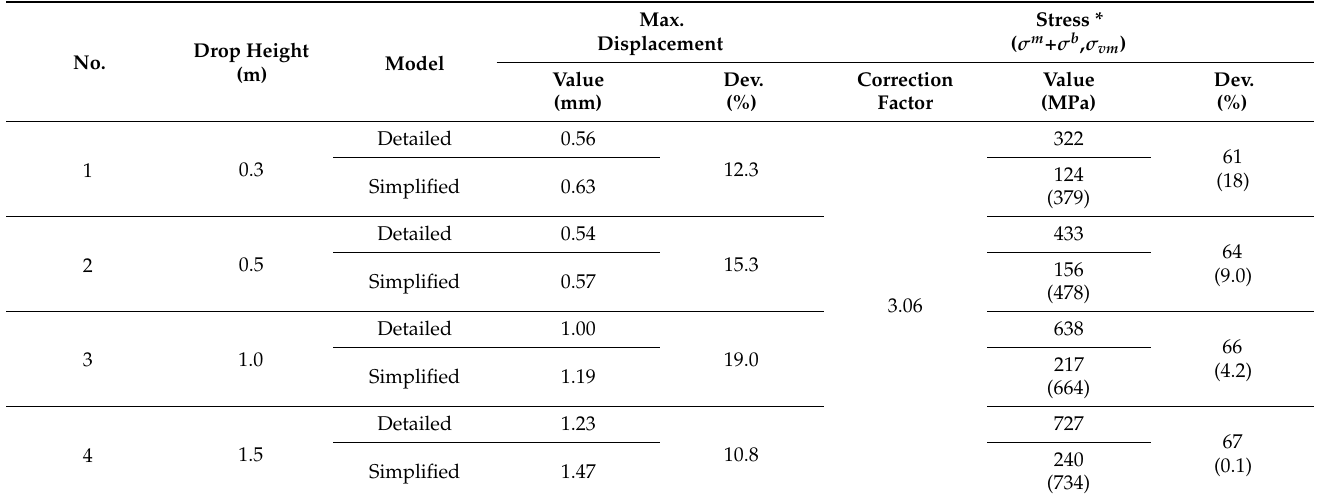
Table 8. Results of the dynamic analyses for the fully de-bonded